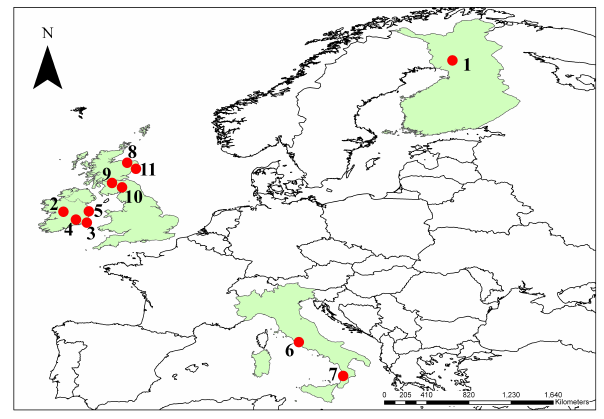
Fig. 1. URFlood project case study locations (numbers relate to Table 1).